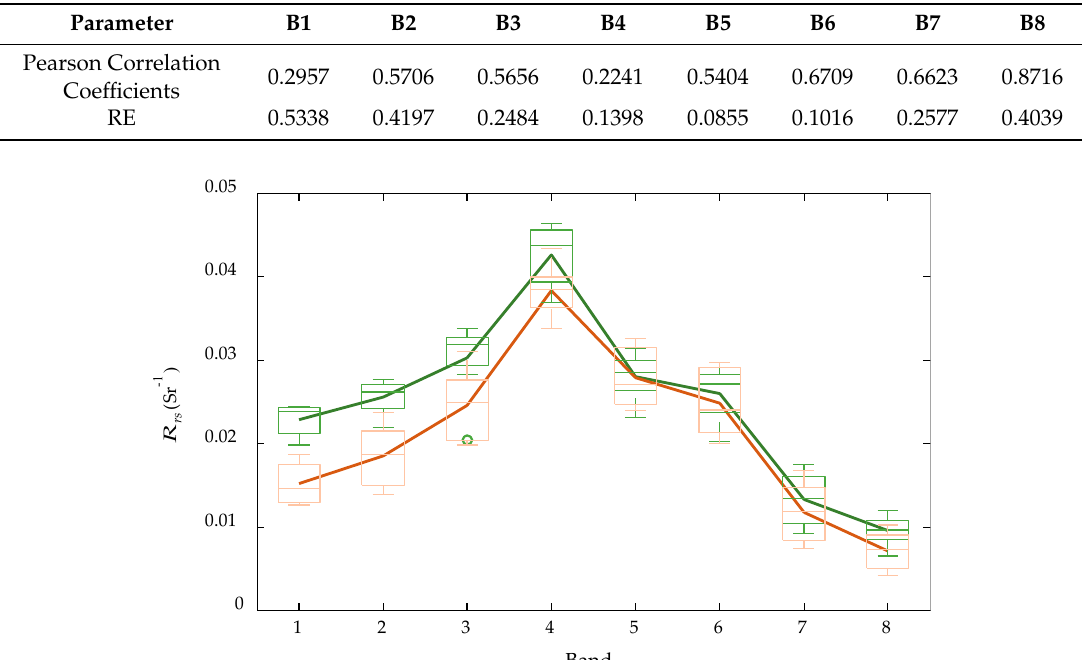
Figure 2. Comparisons of atmospheric corrected and in situ simulated data of GOCI. The green line is the mean remote sensing reflectance of the image after atmospheric correction for 10 stations, the brown line is in situ measured mean remote sensing reflectance for 10 stations.